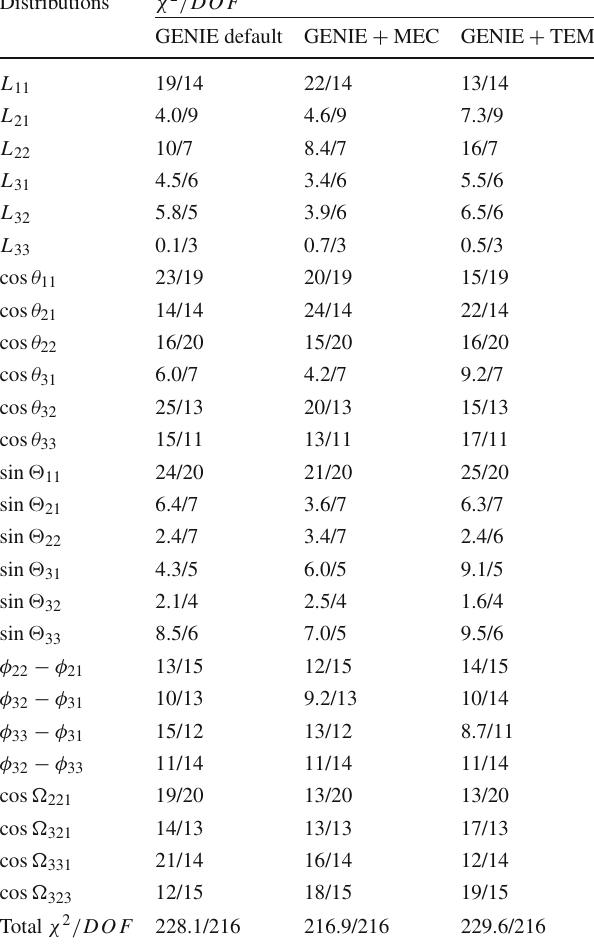
Table 10 χ 2 test results for dynamically significant variables for all three GENIE models. Only the uncorrelated statistical uncertainties from data are used in forming the χ 2 . Contributions from systematic uncertainties are not included. The last five listed distributions are not included in the total χ 2 / DOF since these quantities can be expressed in terms of